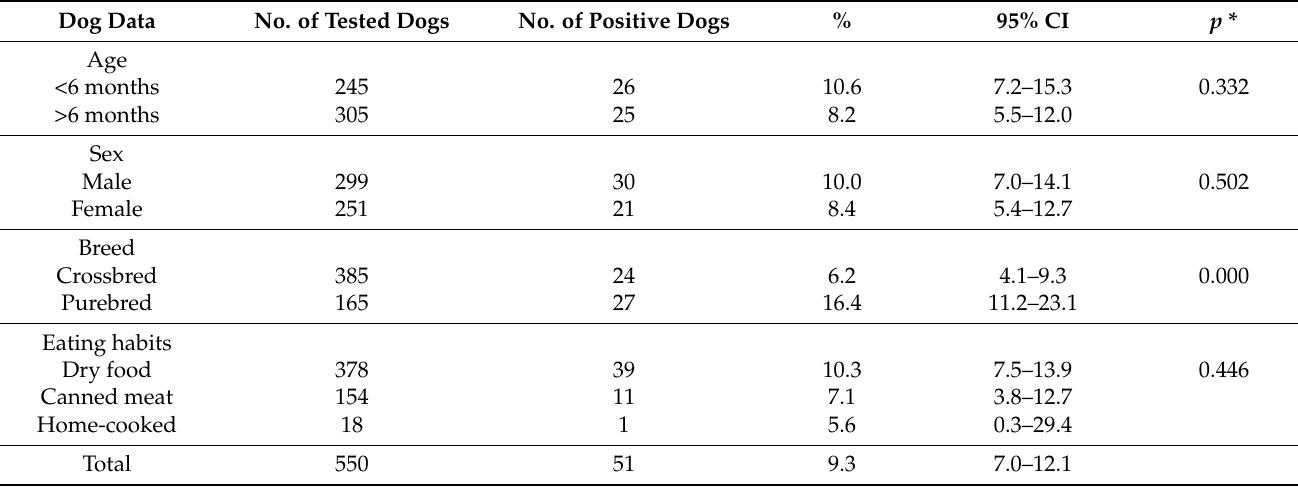
Table 2. Dog data and positivity for Campylobacter coli .